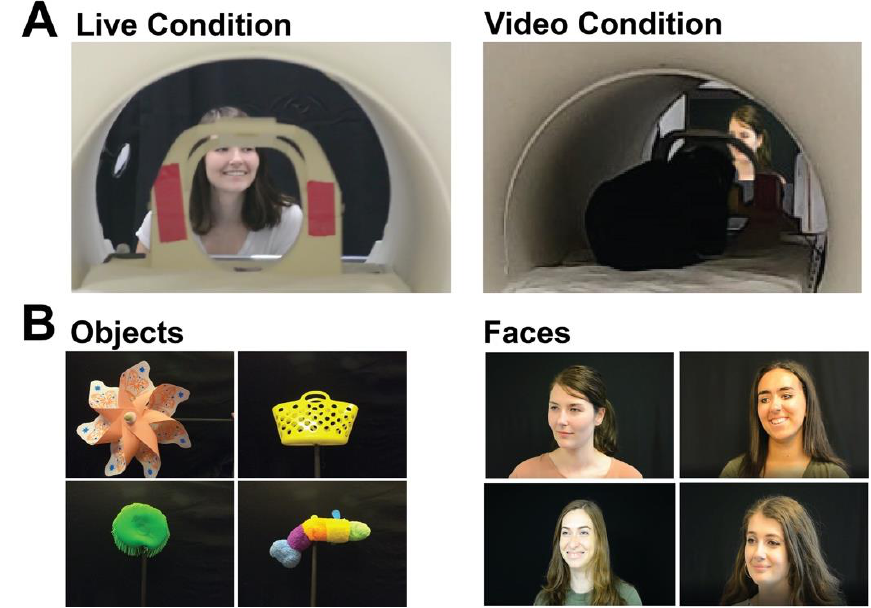
Figure 1. Presentation format and stimuli. ( A ) Examples of what dogs and humans saw when viewing live (left) and video (right) conditions (note image of the same actor is projected on a screen). ( B ) Stimuli examples of objects (left) and faces (right).